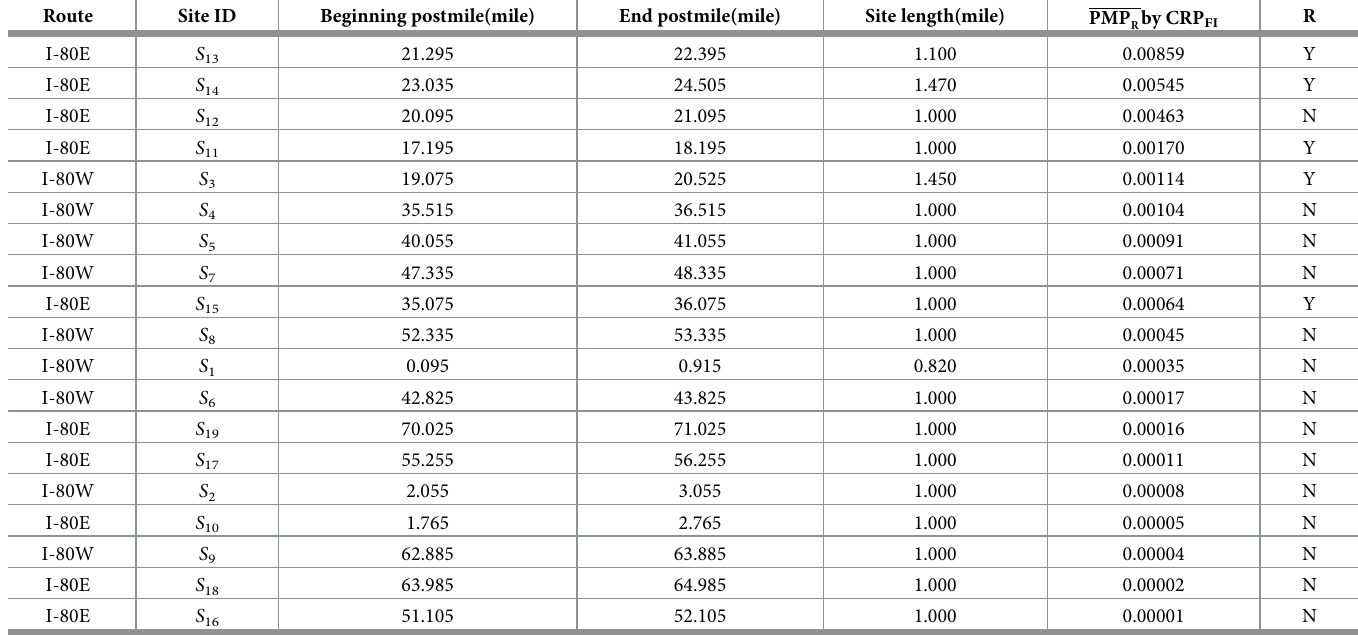
Table 3. Site rankings evaluated based on the PMP